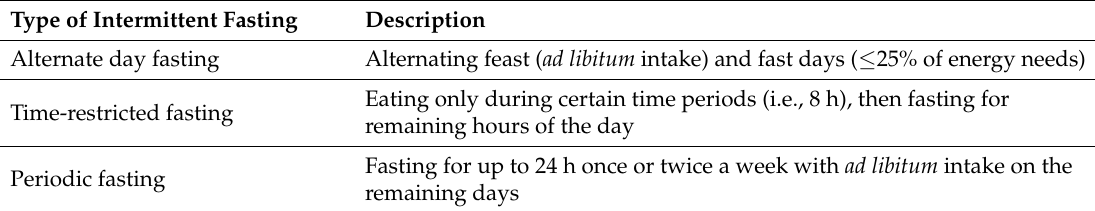
Table 2. Summary and brief description of types of intermittent fasting (IF). Adapted from [37] and used with